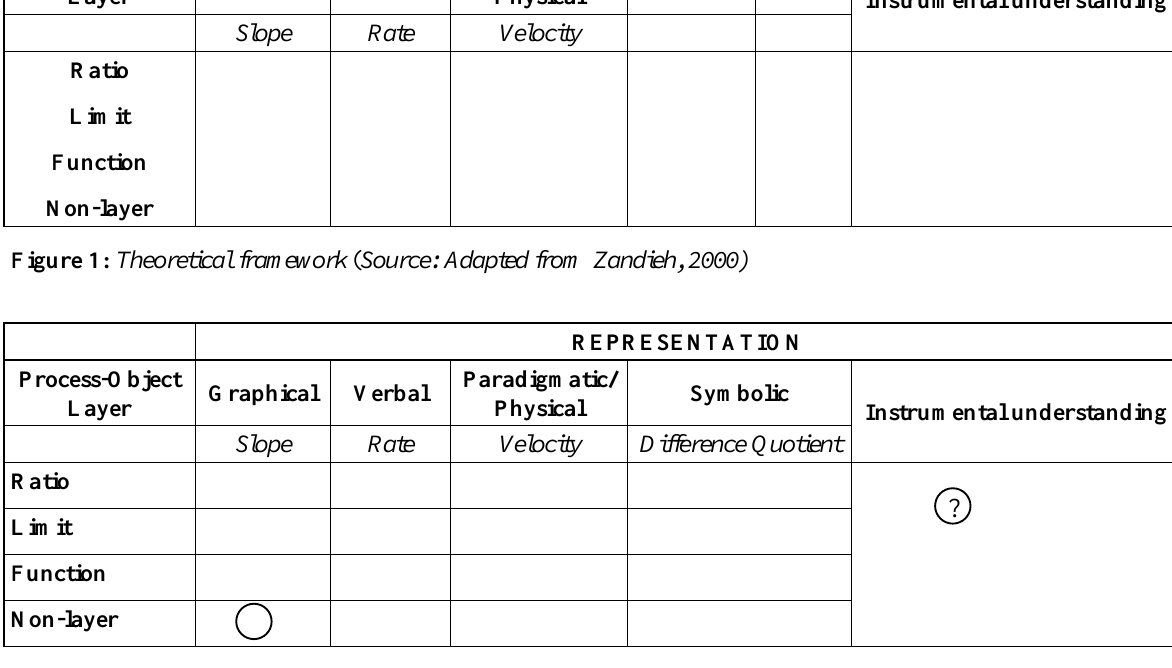
Figure 2: Nompilo’s description of the derivative